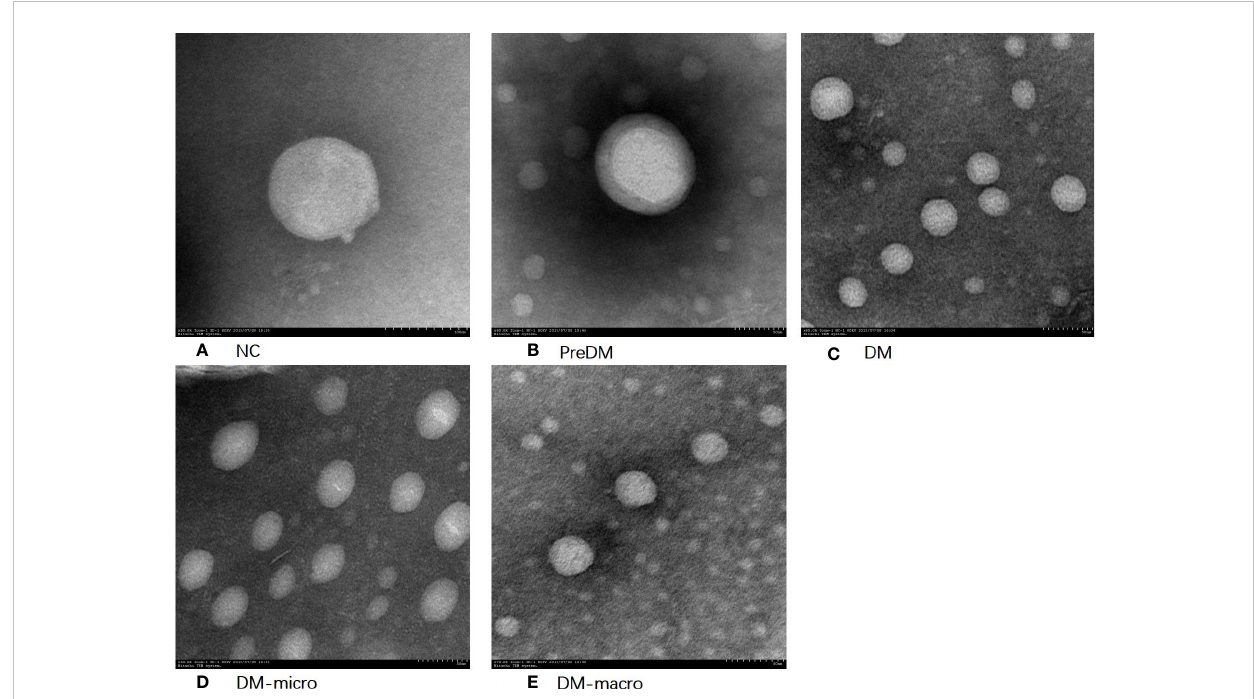
FIGURE 2 Morphology of uEVs observed by TEM. (A) . Morphology of uEVs under TEM in NC. (B) . Morphology of uEVs TEM in Prediabetes. (C) . Morphology of uEVs under TEM in Diabetes with normal proteinuria. (D) . Morphology of uEVs under TEM in Diabetes with microalbuminuria. (E) . Morphology of uEVs under TEM in Diabetes with